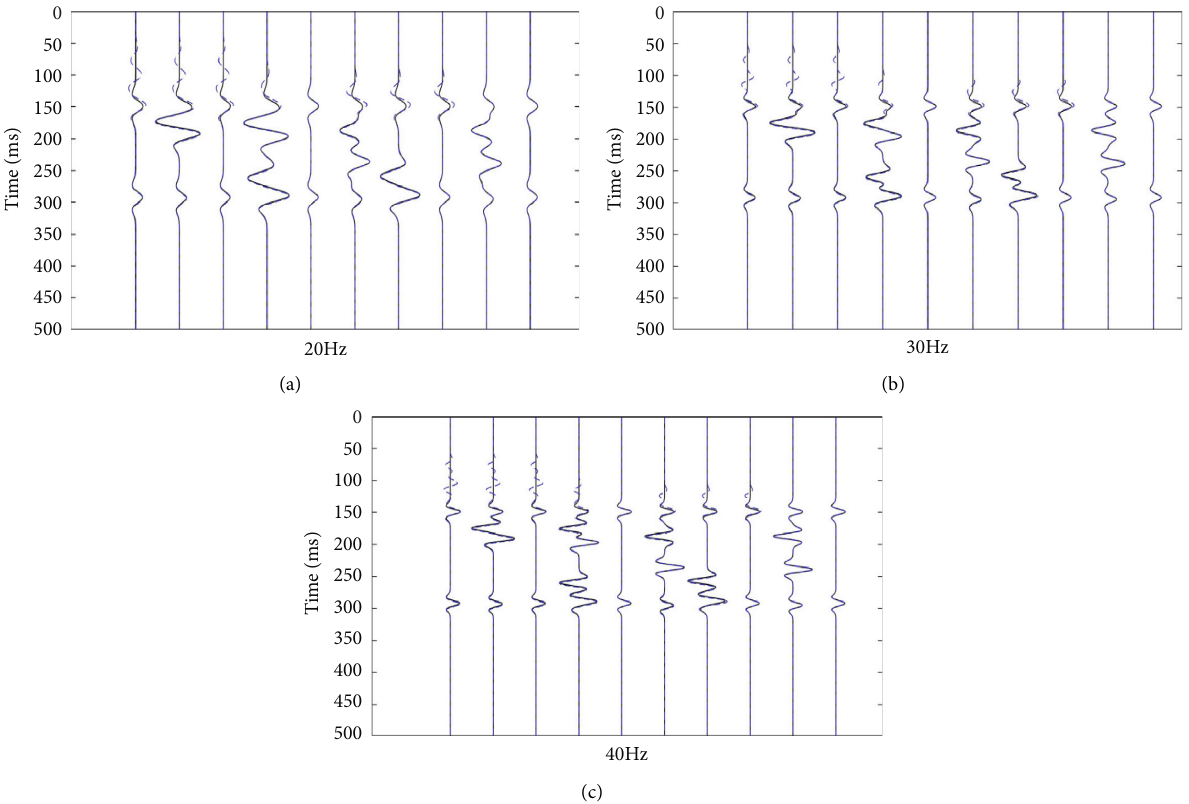
Figure 7: Comparison of waveforms of channel reservoirs with upper interference and noninterference at different frequencies. (a) 20Hz. (b) 30 Hz. (c)